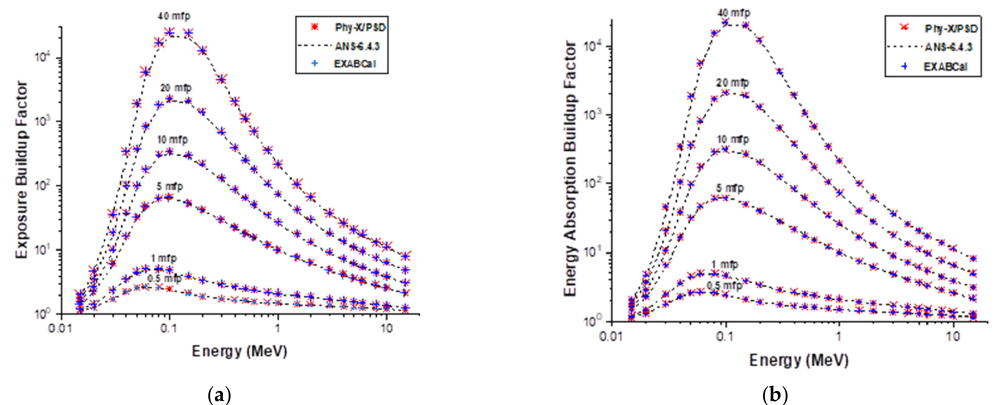
Figure 1. ( a ) EBF and ( b ) EABF of water obtained compared with those of the standard ANSI/ANS-6.4.3 at different mfp’s.